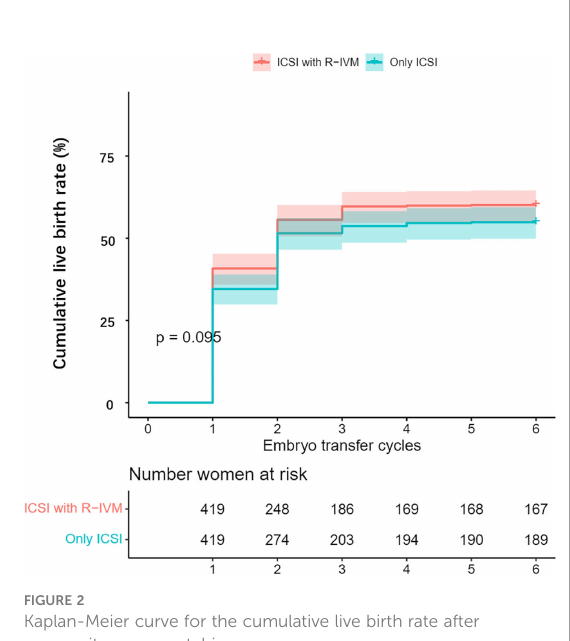
FIGURE 1 Kaplan-Meier curve for the cumulative clinical pregnancy rate after propensity score matching.